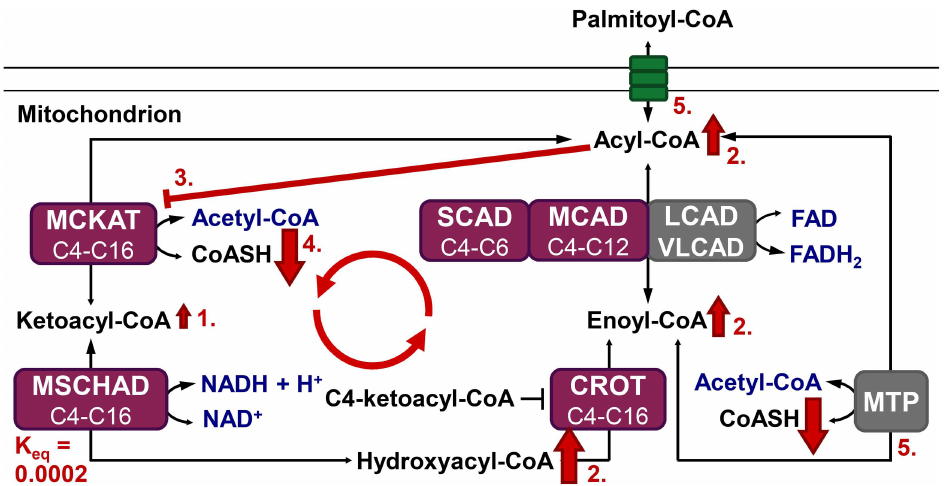
Fig 6. Elucidating the mechanism of flux decline. 1. Upon substrate overloadwith cytosolic palmitoyl-CoA, MCKAT’s ketoacyl-CoAsubstratesstart to accumulate. 2. The unfavourable equilibriumconstant of the preceding enzyme, medium/short-chainhydroxyacyl-CoA dehydrogenase, works as an amplifier, leadingto the accumulation of upstream CoA esters, including acyl-CoA esters. 3. These acyl-CoA esters are at the same time products of MCKAT and inhibit its alreadylow activity further. 4. Finally, the accumulationof CoA esters leads to a sequestration of free CoA. CoA being a cofactor for MCKAT, its sequestration limited the MCKAT activity even further, thus completingthe vicious cycle. 5 . Since CoA is also a substrate for distant enzymes (such as MTP), it efficiently communicates the ‘traffic jam’ at MCKAT to the entire pathway.